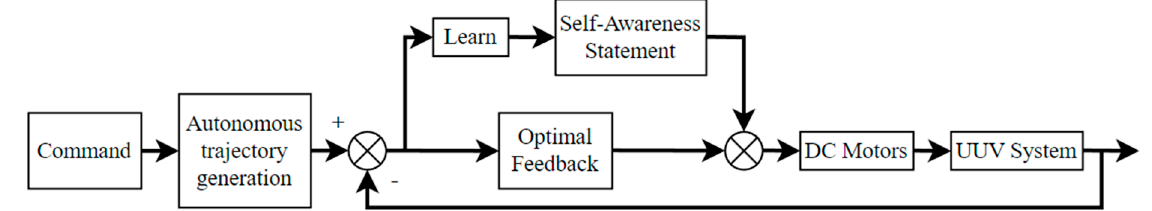
Figure 5. Topology of deterministic artificial intelligence [18] applied to unmanned underwater vehicles that are actuated using DC motors.